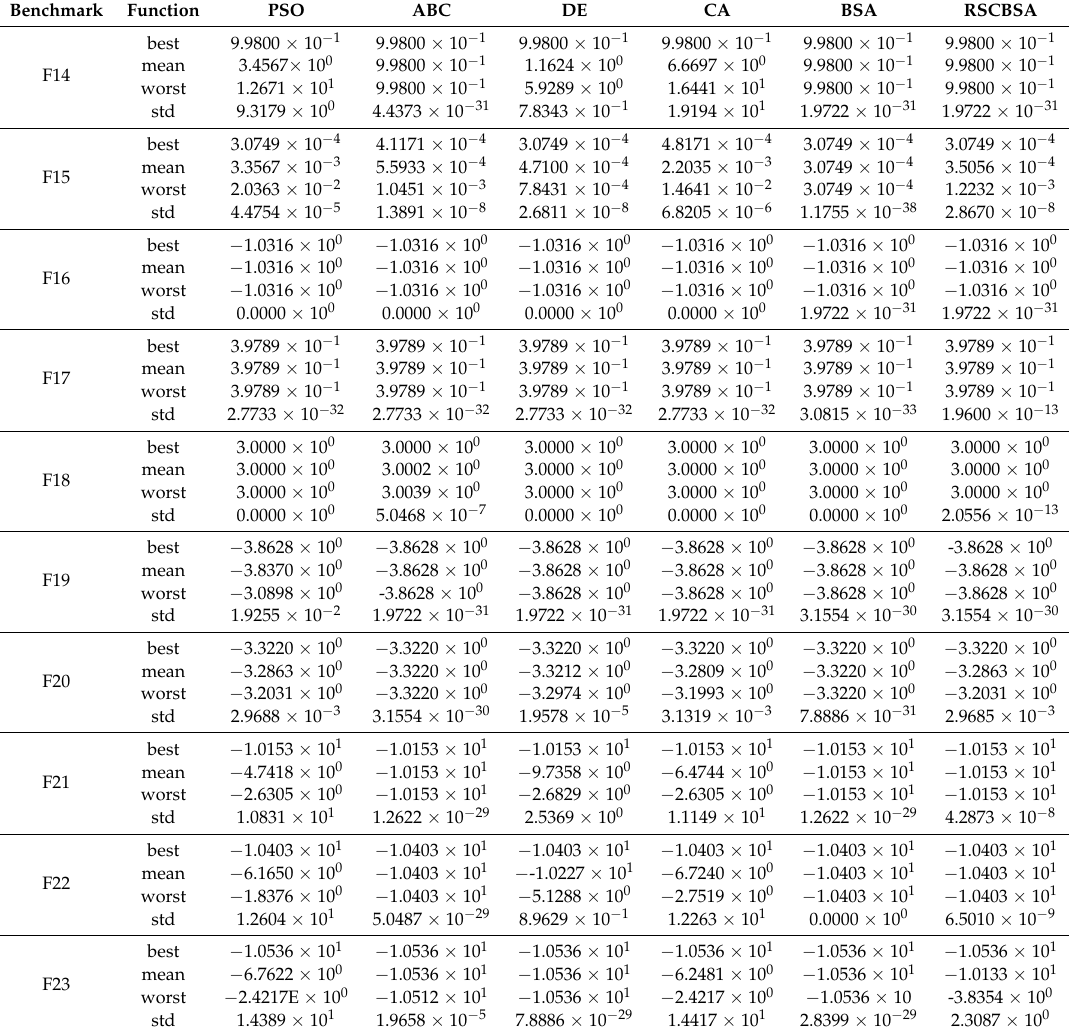
Table 5. Results of fixed-dimension multimodal benchmark functions.